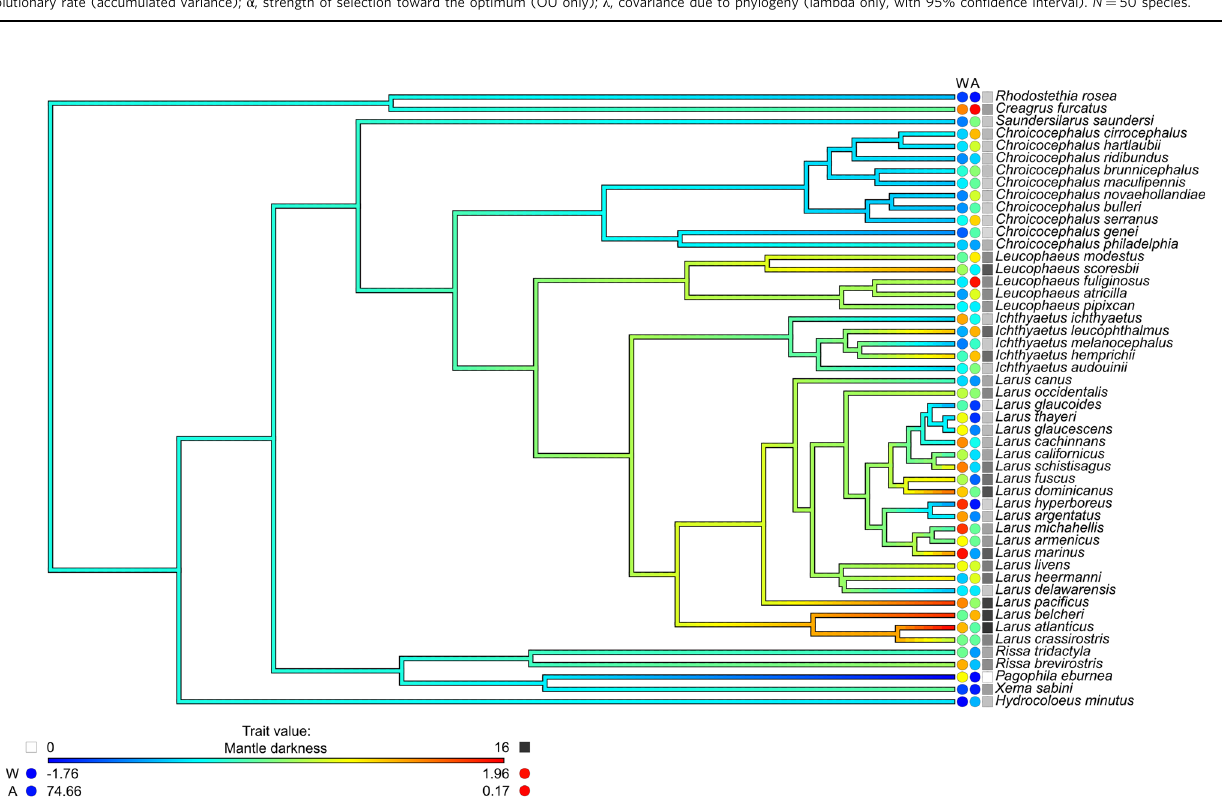
Candidate models for selection are shown, with the results of likelihood ratio tests (LRT). The model with most support is listed fi rst. The regression estimates are labelled as follows: β 0 , intercept; WL, standardized wing loading; AL, absolute latitude (distance of the species ’ breeding and resident range from the equator). The following parameters for each phylogenetic model are also shown: σ 2 , evolutionary rate (accumulated variance); α , strength of selection toward the optimum (OU only); λ , covariance due to phylogeny (lambda only, with 95% con fi dence interval). N = 50